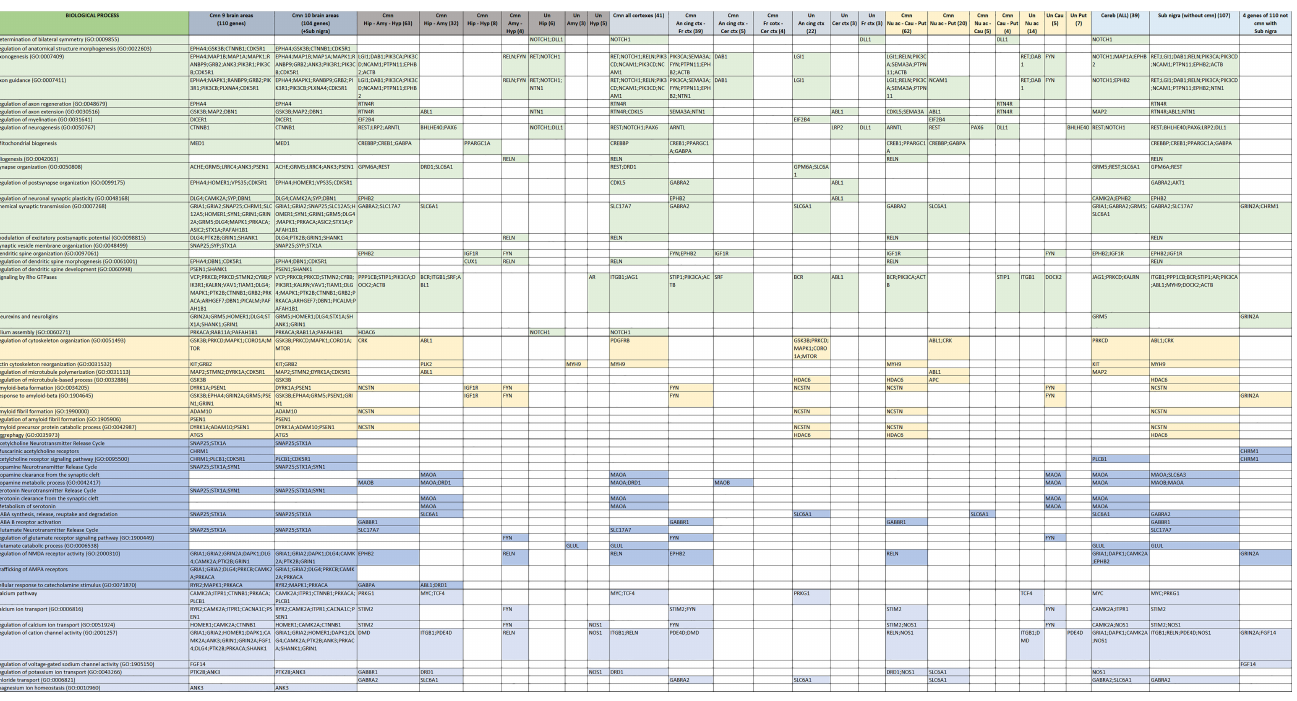
Figure 6. Selected results of biological functions involved in structural development and neurotransmission.